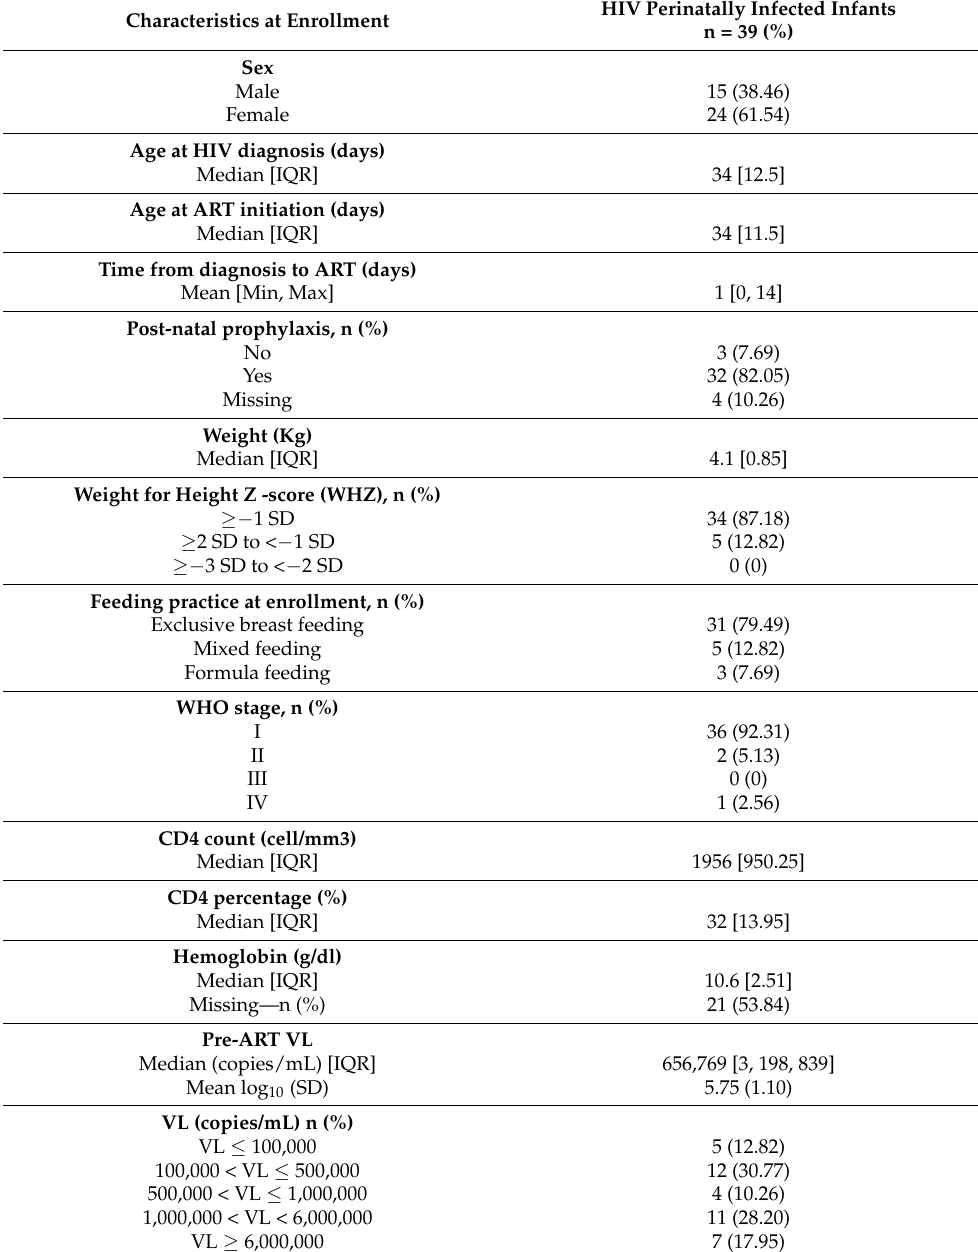
Table 1. Characteristics of infants included in the analysis at